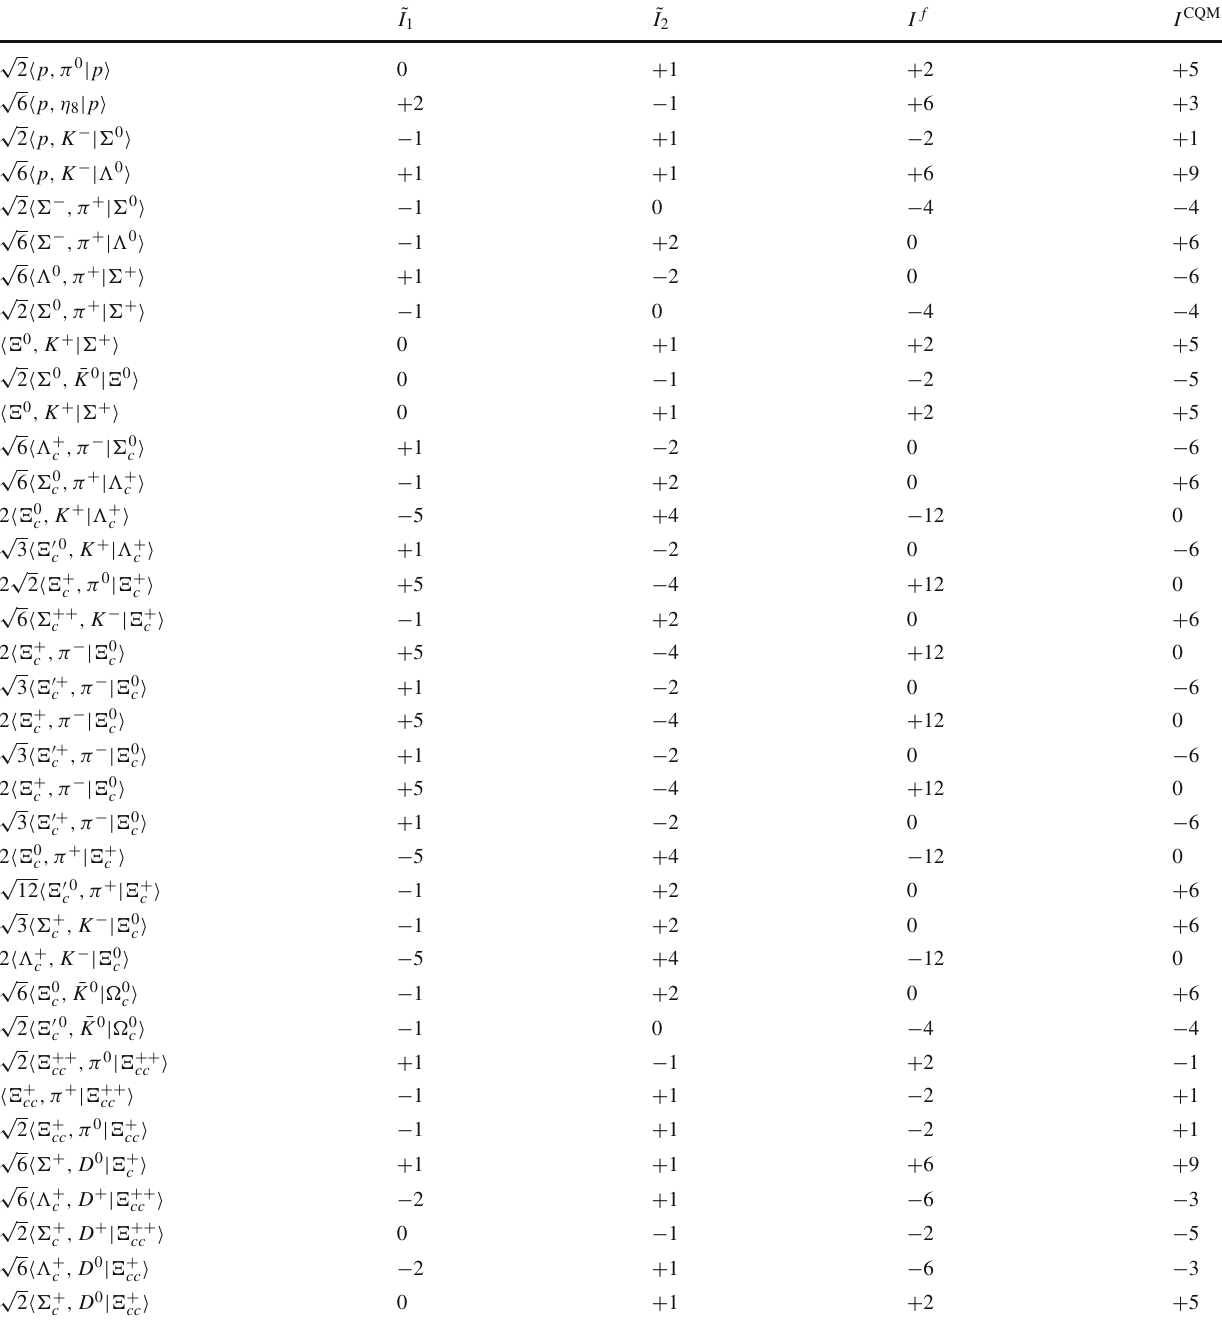
Table 18 Values of tensor invariants for the strong transitions B i → B f + M k . I f and I CQM are related to ˜ I 1 and ˜ I 2 by I f = 4 ˜ I 1 + 2 ˜ I 2 and I CQM = 4 ˜ I 1 + 5 ˜ I